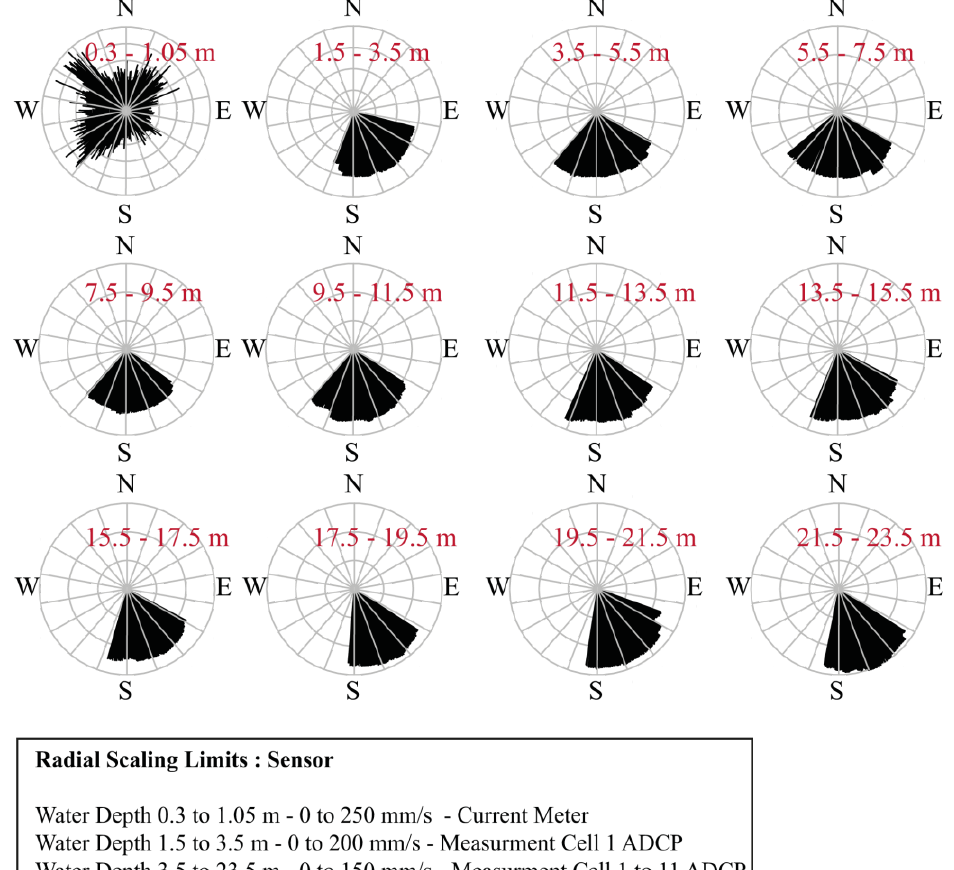
Figure 10. Flow directions over all depths per cardinal direction recorded by current meter and acoustic doppler current profiler. The ranges listed in red represent the measurement water depths. Only the range from 0.3 to 1.05 m was recorded by the acoustic doppler current meter (ADCM). The remaining data were recorded by the acoustic doppler current profiler (ADCP). Data shown covers the period from 1st of September to 18th of